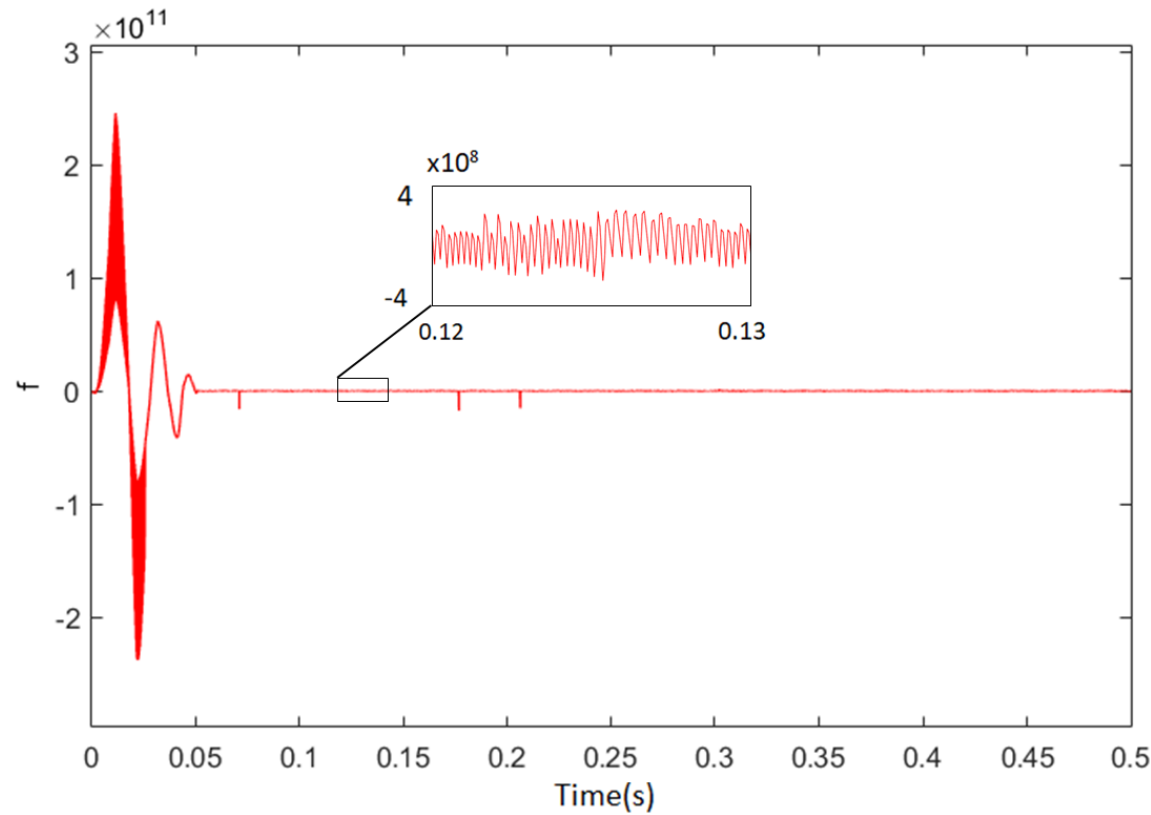
Figure 10. OFFNN adaptation curve.